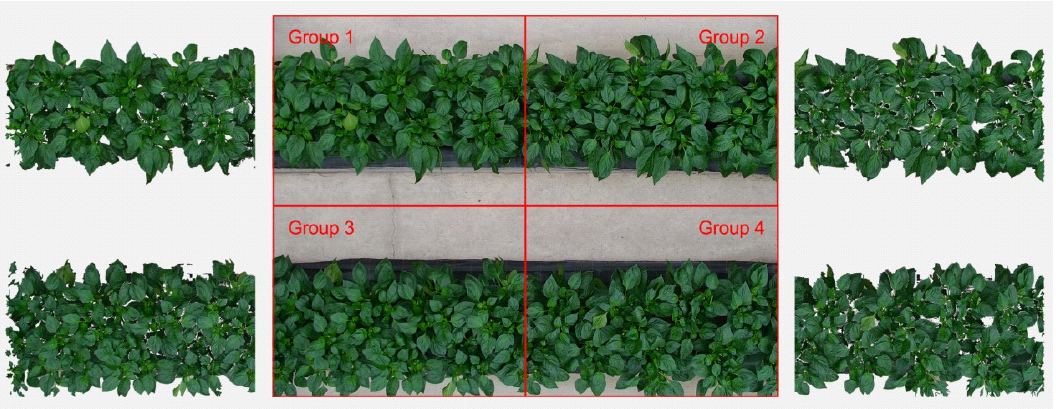
Figure 1. Image grouping scheme and image separation effect of pepper in the greenhouse.